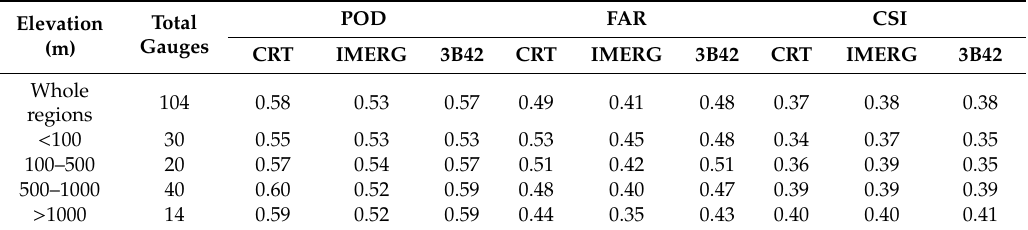
Table 4. Error metrics of categorical validation statistics for CRT, IMERG, and 3B42 on daily precipitation scale in di ff erent elevation ranges.